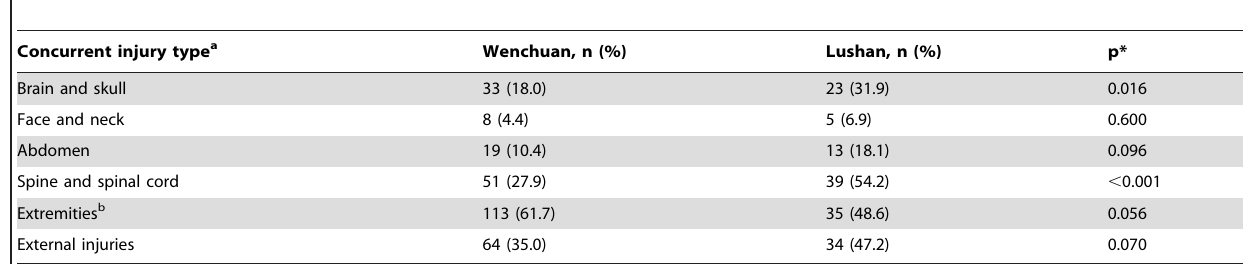
Table 3. Comparison of the prevalence and types of injuries co-occurring with chest injury in patients admitted to our hospital after the Wenchuan and Lushan earthquakes.